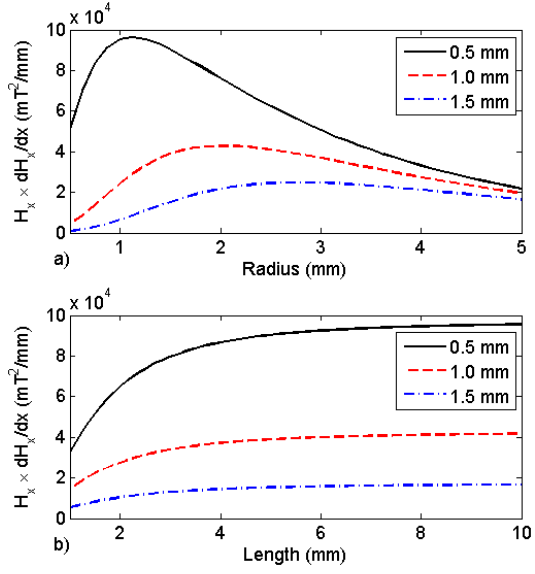
Figure 3. Product of the theoretical magnetic field with the magnetic field gradient ( a ) versus the radius of the magnet and ( b ) versus its length, for three different standoff distances (0.5 mm, 1.0 mm, and 1.5